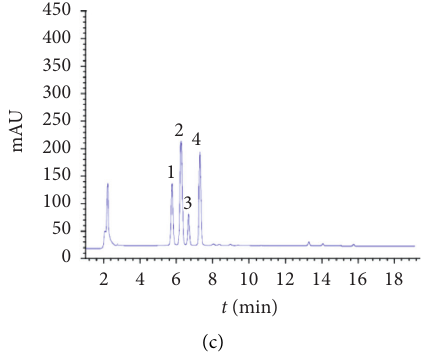
Figure 2: HPLC-DAD profile 320nm (a), 360nm(b), and 560nm (c) of the black currant pomace water extracts.